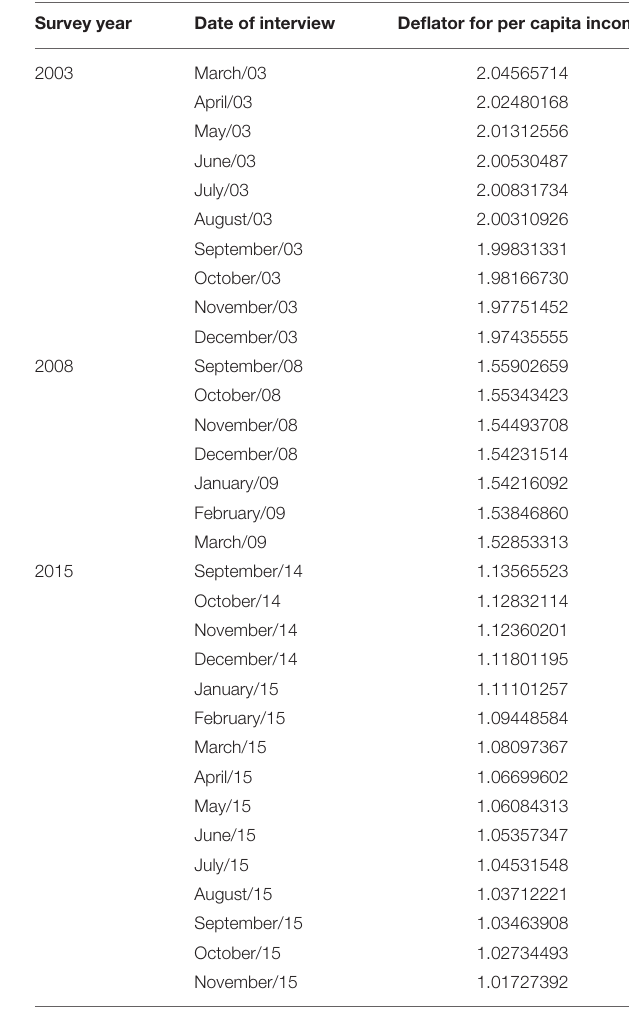
TABLE 4 | Deflators adopted for updating the household income per capita to the reference period of the ISA-Capital 2015 (December 2015) according to the date of the interviews of the